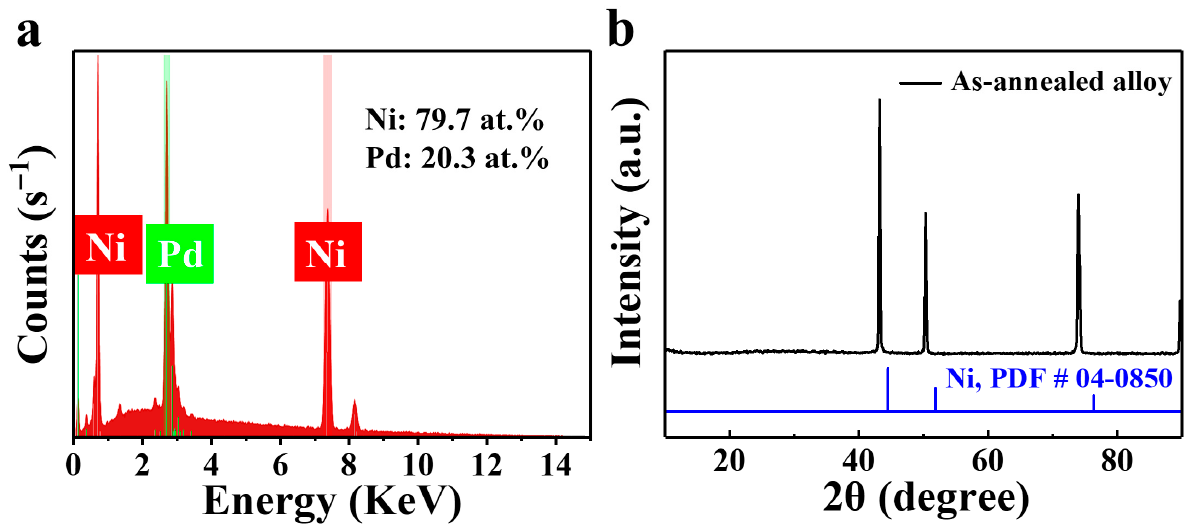
Figure 2. ( a ) Typical EDS spectrum and the average chemical compositions (inset) of the as-annealed Ni 80 Pd 20 alloy. ( b ) XRD pattern of the as-annealed Ni 80 Pd 20 alloy.